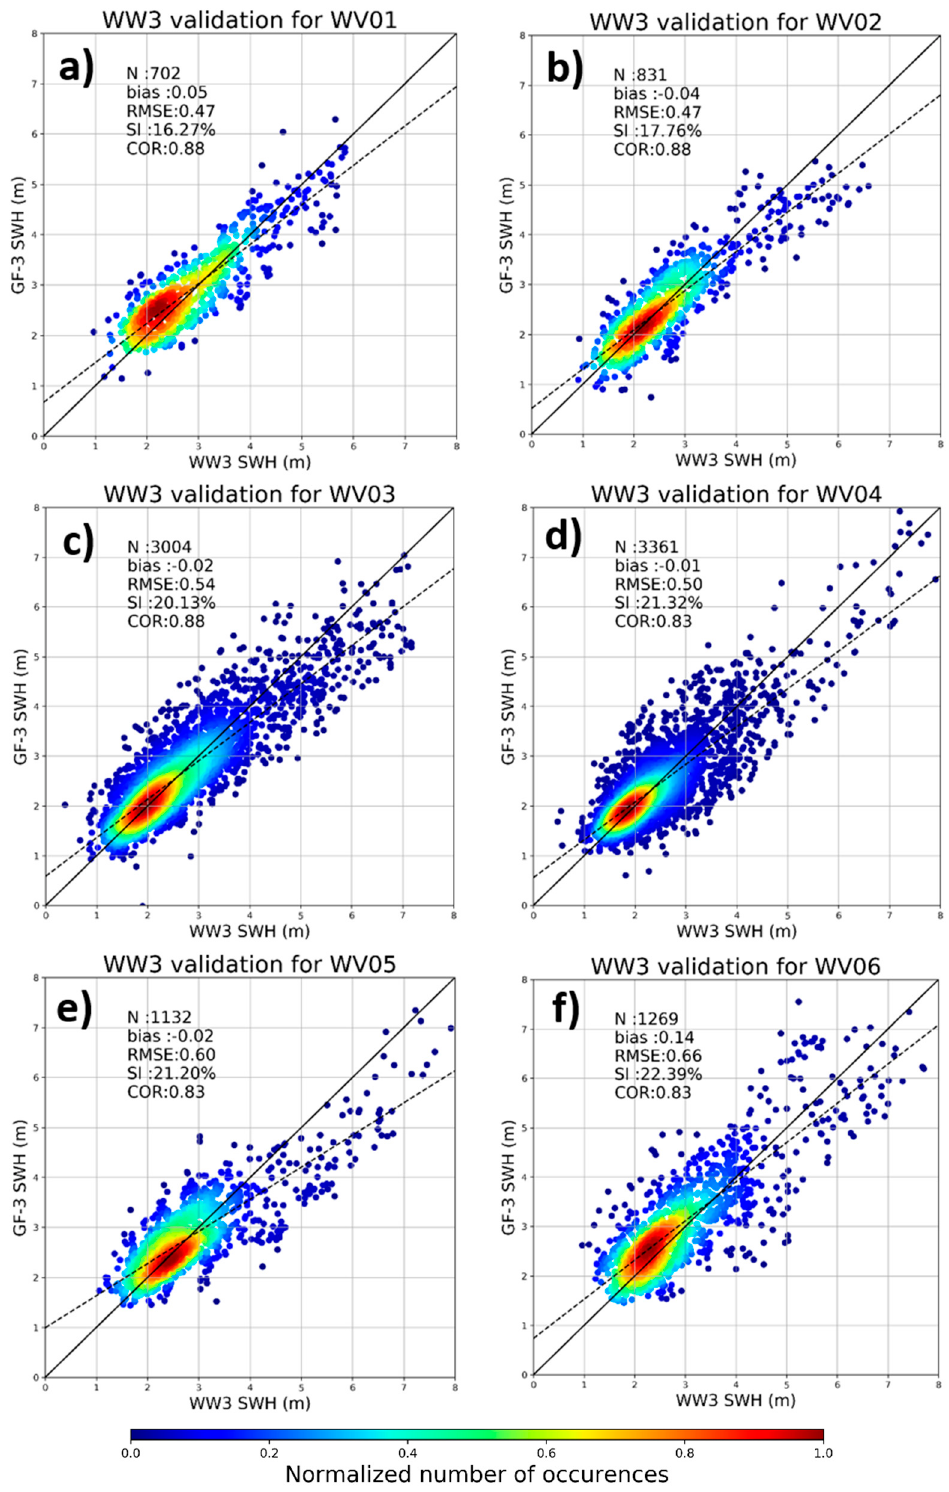
Figure 7. Scatter plots of SWH retrieved from GF-3 using the QPCWAVE_GF3 empirical model versus WW3 hindcasts for incidence modes of WV01 ( a ), WV02 ( b ), WV03 ( c ), WV04 ( d ), WV05 ( e ) and WV06 ( f ).